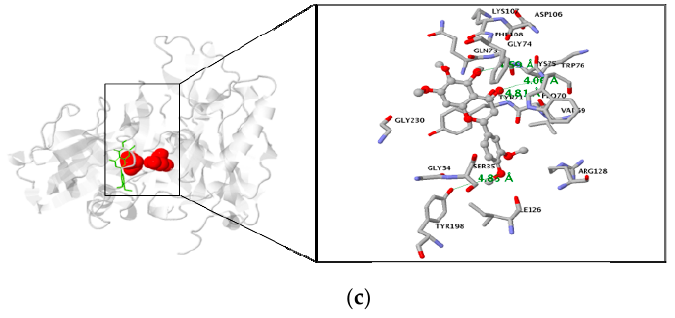
Figure 5. Comparison of in silico docking poses for polymethoxyflavones (PMFs): ( a ) nobiletin, ( b ) tangeretin, ( c ) sinensetin. Representative binding mode of the most stable docking poses of PMFs with BACE1. BACE1 is expressed as a solid ribbon diagram and PMFs as a stick depiction. Left: The complete view of the docking pose of PMFs. Right: The close-up view of the calculated PMFs–BACE1 docking modes. Asp32 and Asp228 are the active catalytic center residues shown in italics. Hydrogen bond interactions between PMFs and the human BACE1 residues are presented as blue ( a ) and green dots ( b , c ). Table 2. Molecular interactions of BACE1 sites with polymethoxyflavones (PMFs).